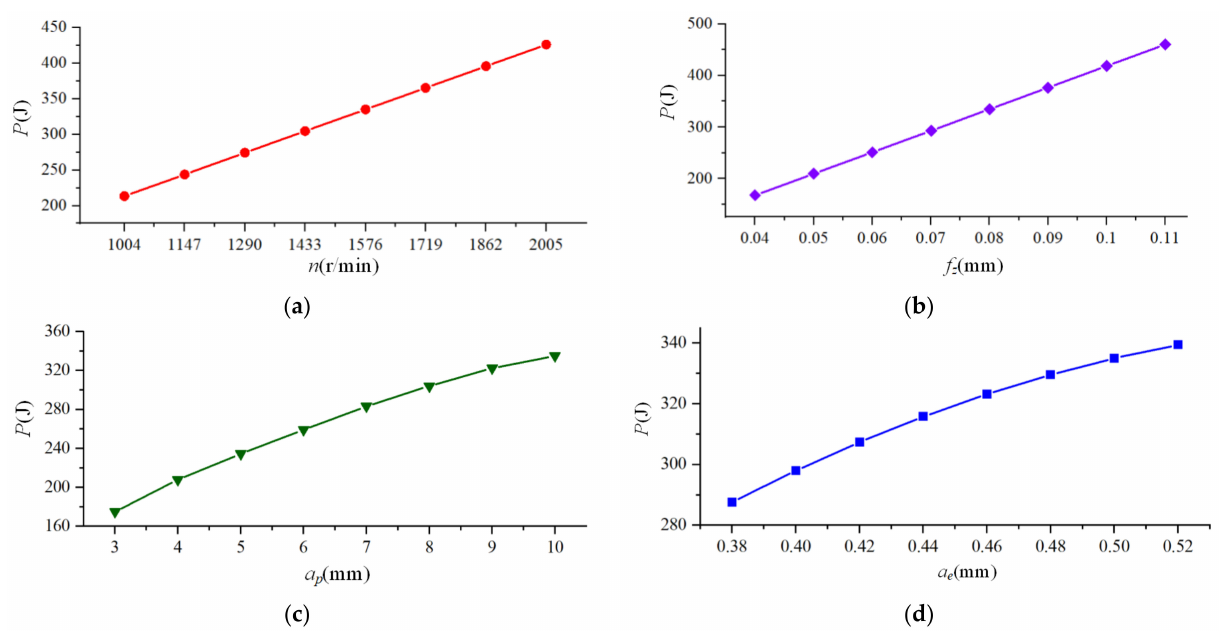
Figure 16. Influence of process parameters on main cutting force energy consumption of milling cutter, ( a ) spindle rotational speed, ( b ) feed per tooth, ( c ) cutting depth, ( d ) cutting width.